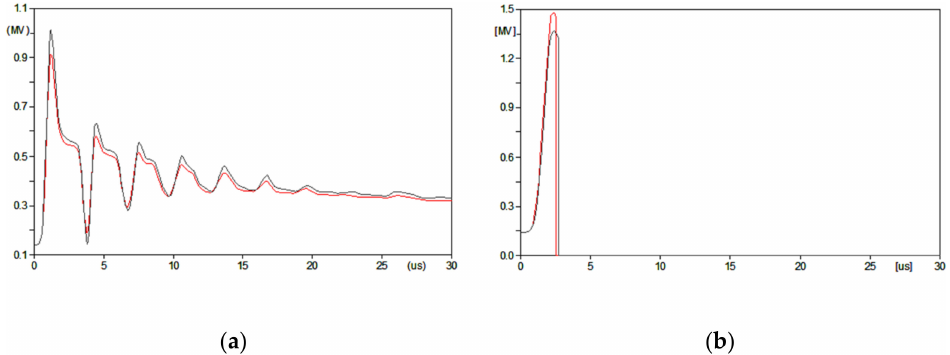
Figure 9. Voltage across insulator (most stressed phase) against time when a 150 kV OHL equipped with MT4 grounding arrangement is struck by lightning. Red line: full circuit model; black line: pi-circuit model. ( a ) ρ g = 600 Ω · m, I P = 39 kA, t F = 1.26 µ s, t H = 300 µ s; ( b ) ρ g = 600 Ω m, I P = 99 kA, t F = 2.44 µ s, t H = 300 µ s.